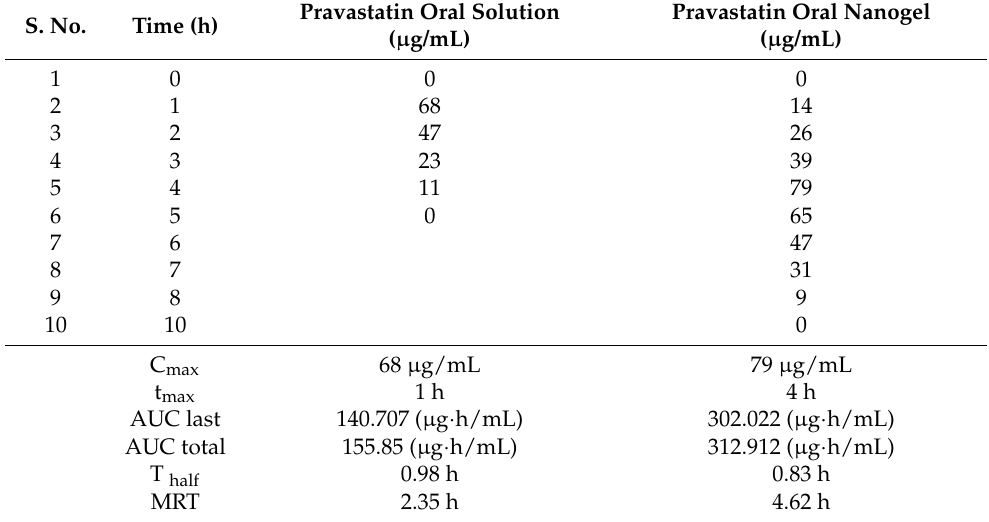
Table 4. Summary of values of peak plasma concentration (C max ), time of C max attainment (t max ), Area under curve (AUC), and Mean residence time (MRT) of pravastatin oral solution and pravastatin oral nanogel.